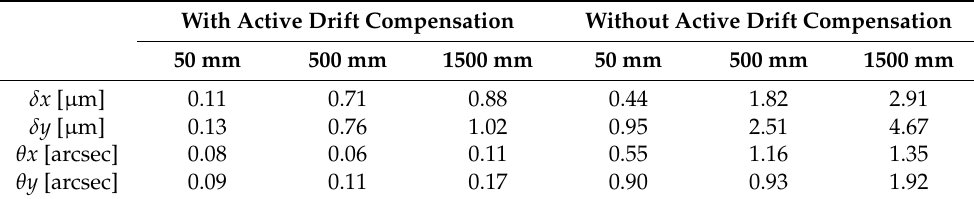
Table 1. Stability tests of the signals with and without the active drift compensation at the positions of 50 mm, 500 mm and 1500